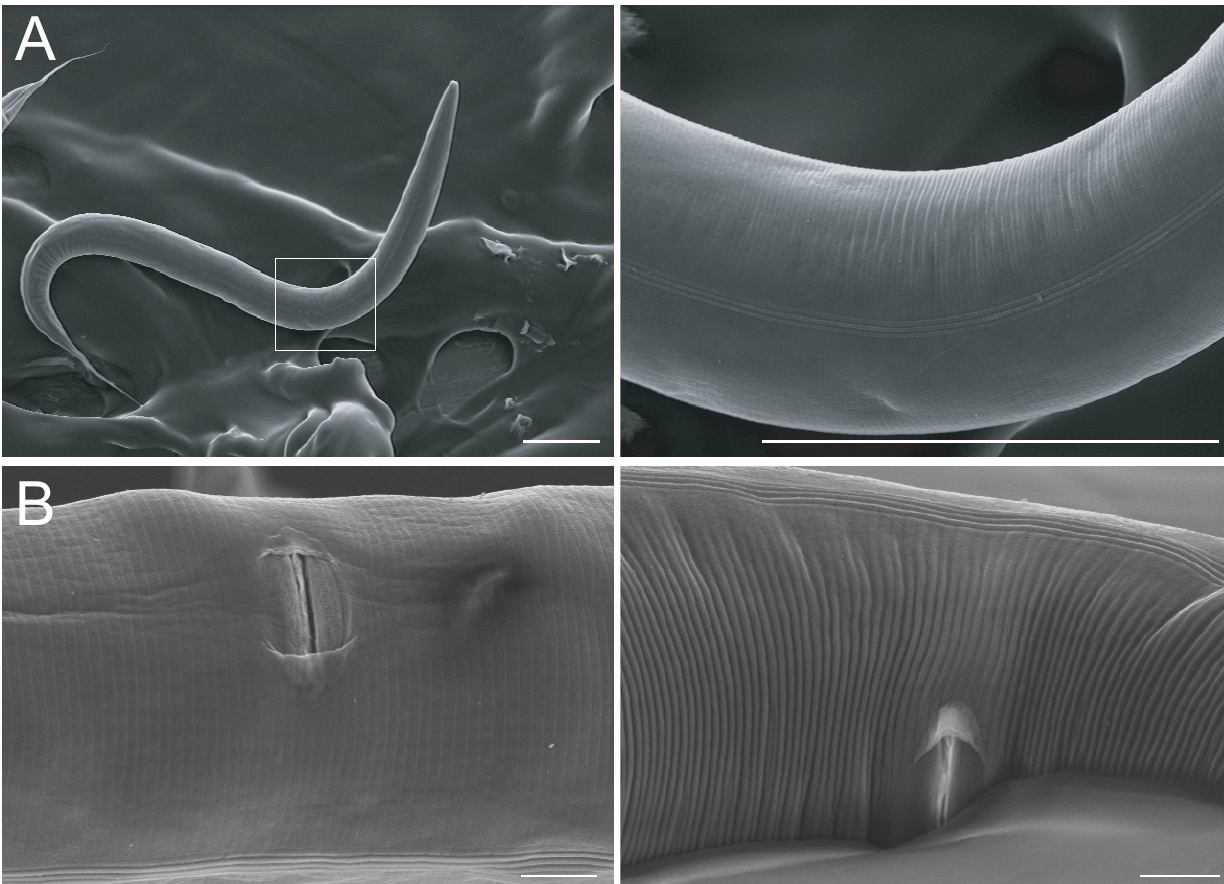
Figure 2. Soil conditions do not cause cuticle damage. SEM images of hermaphrodites grown in soil plate conditions. (A) Low- (left) and high- magnification (right) images of a worm grown for five days in soil, showing pristine ultrastructure of the cuticle. The three parallel alae (ridges running transversely across the cuticle) are clearly visible in the high-magnification view. (B) Soil conditions also do not damage cuticle surrounding the vulva. Two representative specimens are shown. Scales bars represent 100 microns in A and 10 microns in